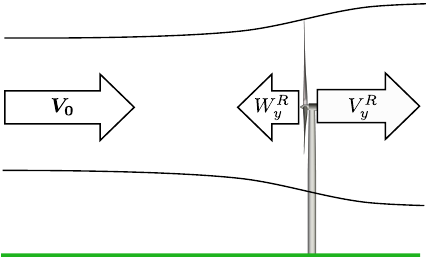
Figure 2. At the rotor plane, the free-inflow wind velocity, V 0 , is reduced by the axial induction, W R y . A sensor at the rotor plan will therefore measure the reduced velocity, V R r,y , in the axial direction.